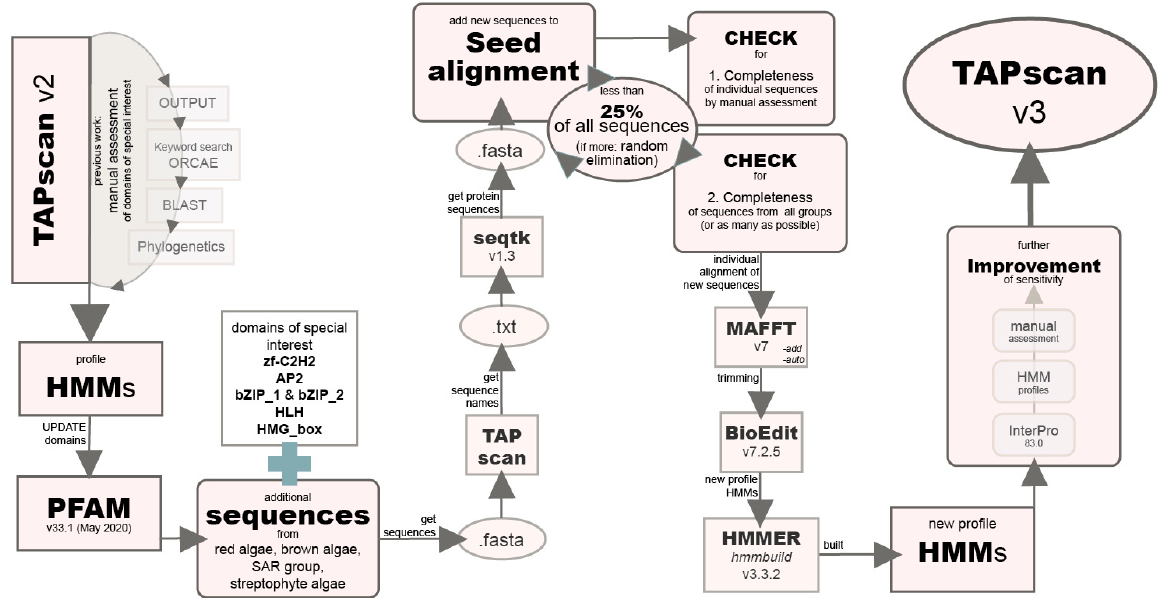
Figure 2. Flow chart illustrating the steps of improving the sensitivity of selected profile hidden Markov models (HMMs) towards algae by adding diverse algal sequences. The first step was to update all PFAM domains included in TAPscan v2 to the latest version (PFAM v33.1). Subsequently, additional sequences were added to the seed alignments of six domains of special interest and new profile HMMs were calculated. After further adjustments (described in Section 2.3), TAPscan is now v3.